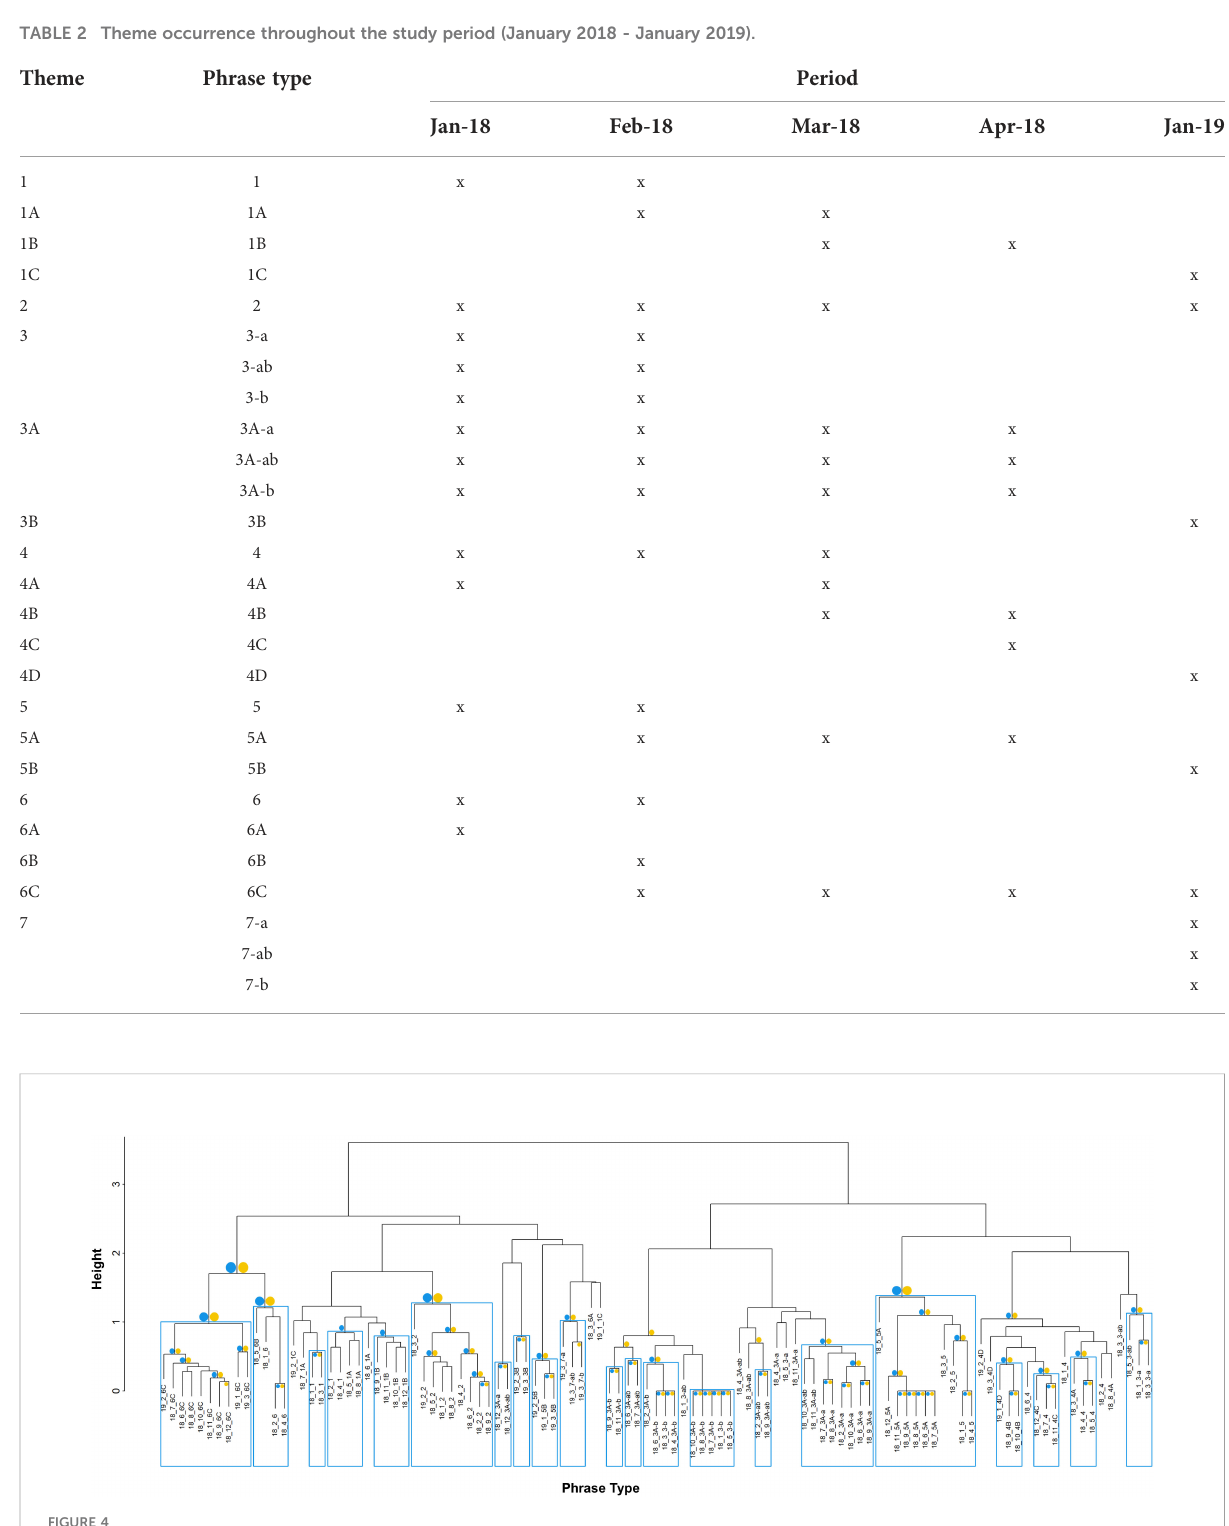
FIGURE 4 Dendrogram of bootstrapped (1000) LSI of average-linkage hierarchical clustered set medians per theme (most representative phrase) per song session. The Cophenetic Correlation Coef fi cient (CCC)=0.89, indicating a good representation of the structure within the data. Multiscale bootstrap resampling is represented by dots: blue (left) indicates AU > 95% and yellow (right) indicates normal BP > 70%. Lower values (no dots) indicate variability in their division whereas branches with high AU values represent stable divisions. Stable and highly supported clusters were marked using rectangles at the highest